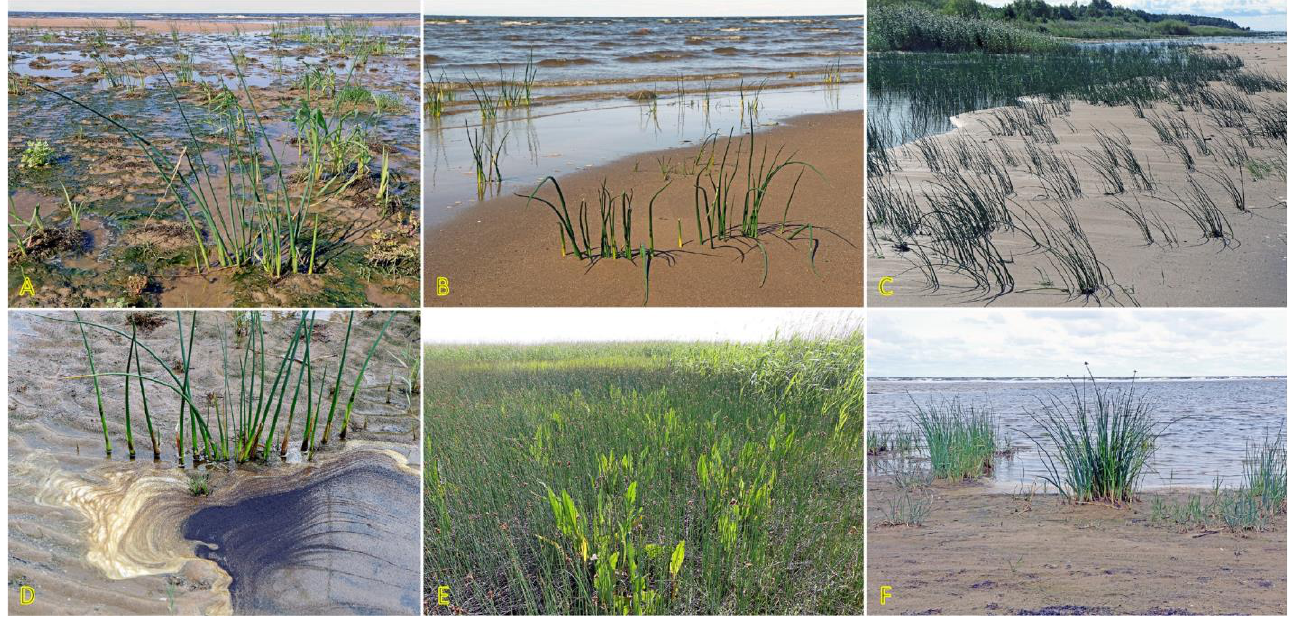
Figure 17. Schoenoplectus tabernaemontani on a permanently wet sandy beach with developing peren- nial vegetation in Salacgr¯ıva, Latvia ( A ), on a wet sandy beach in Ainaži, Latvia ( B ), on a flooding sandy beach on the edge of the permanent lagoon in Ainaži, Latvia ( C ), on a permanent puddle in Ainaži, Latvia ( D ), on salt marsh together with Rumex hydrolapathum and Bolboschoenus maritimus in M¯ersrags, Latvia ( E ), on a wet sandy beach in Lielupe, J¯urmala, Latvia ( F